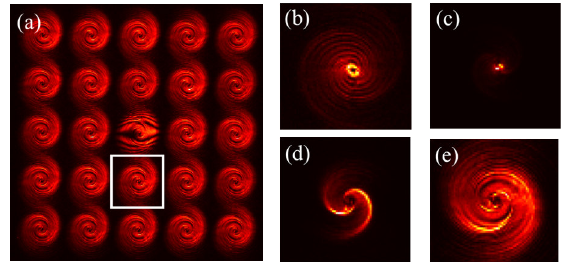
Fig. 3. (a) Cluster of N = 25 replicated DH-PSF at distance change z = 20 mm. The DH-PSF marked with a white square is shown for different distances and, therefore, defocus states in images (b) to (e) ; (b) z = 1 mm ; (c) z = 6.1 mm . Here the light source is in focus; (d) z = 15 mm ; (e) z = 19 mm